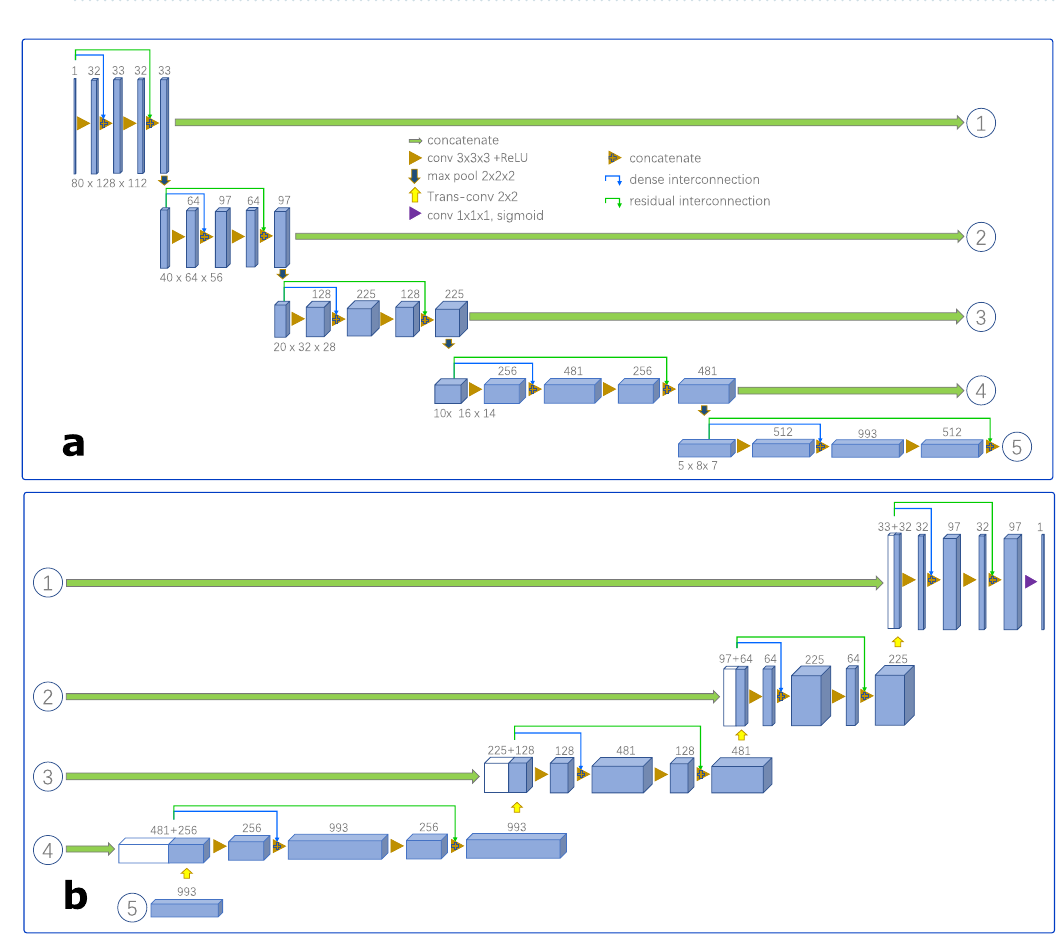
Figure 5. ( a ), ( b ) Sagittal image and label of ROI for segmentation. ( c ), ( d ) Elastically deforming of ROI. ( e ), ( f ) Adding Gaussian noise to ROI, ( g ), ( h ) Filling with 0s (black) beyond the boundary.